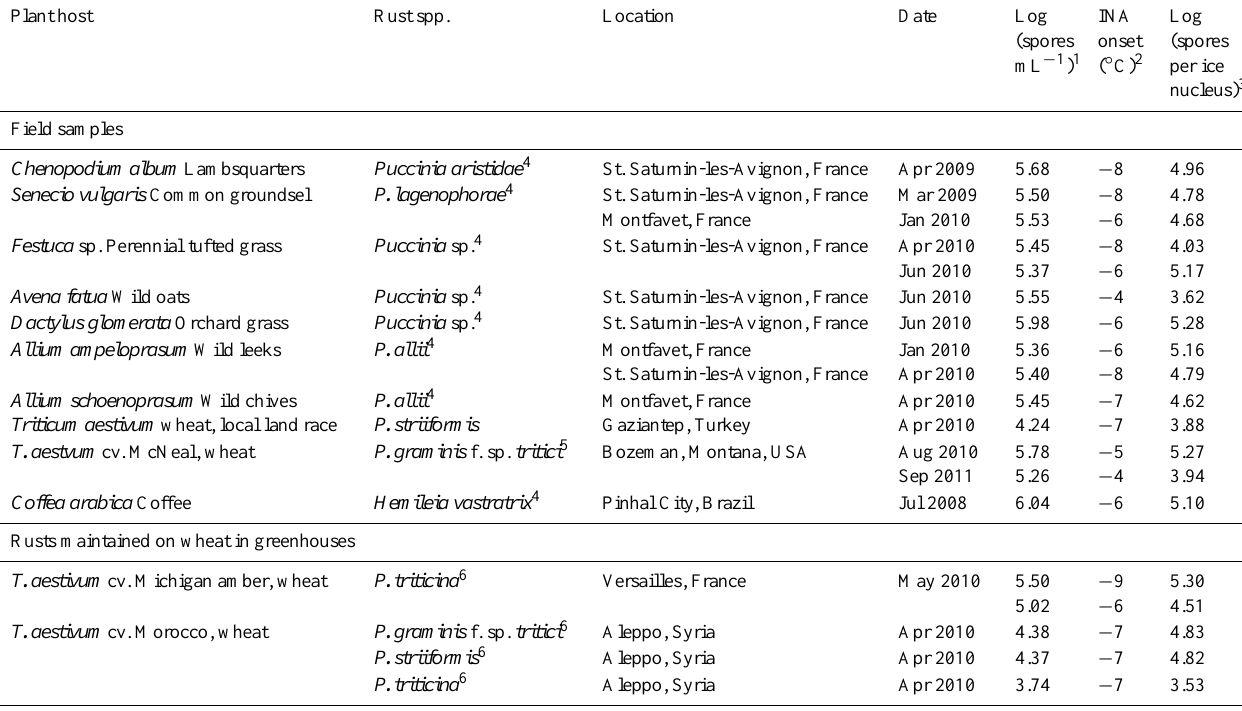
Table 1. Sources of rust urediospores characterized for ice nucleation activity (INA) and bacterial contamination. Plant host Rust spp. Location Date Log